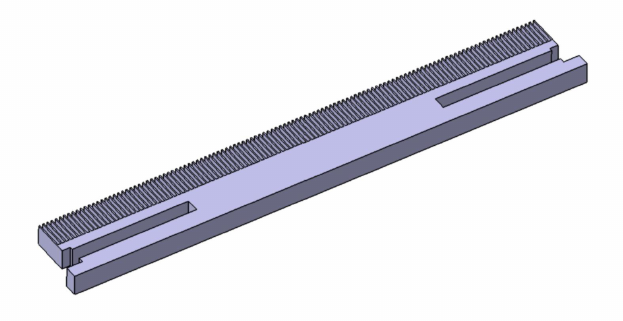
Figure 20. A schematic view of the electrostatic actuator of the SE of the MEMS gyroscope.